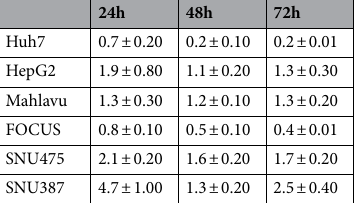
Table 2. IC 50 values of compound 7b in µM concentrations against Huh7, HepG2, Mahlavu, FOCUS, SNU475 and SNU387 cells at 24, 48 and 72 h determined by SRB assay.